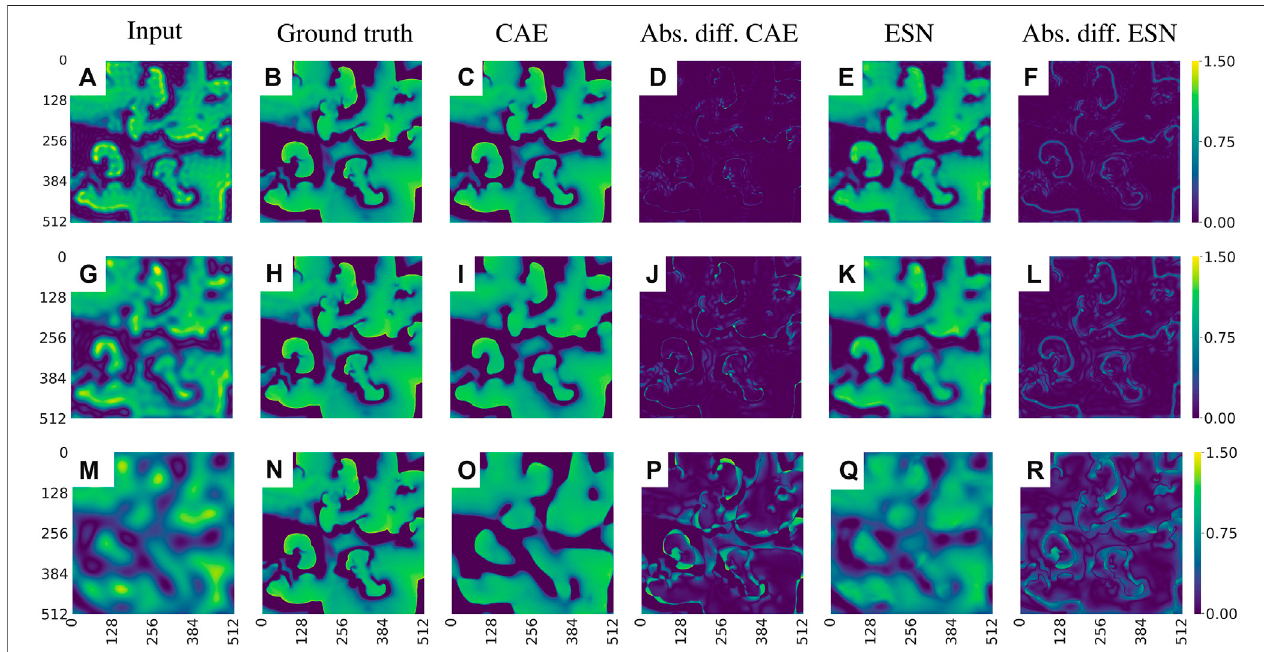
FIGURE 10 | Exemplary visualization of the input and output for both networks, CAE and ESN, when recovering the original data from blurred measurements. (A) – (F) corresponds to case one, where m (cid:2) 20, (G) – (L) to case six with m (cid:2) 14 and (M) – (R) to seven, m (cid:2) 8. Comparing the absolute differences between the prediction and the ground truth [ (D), (J), (P) for the CNN and (F), (L), (R) for the ESN] one recognizes that the CAE and ESN exhibit different patterns. The errors of the CAEareratherpointwisedistributedatsomelocations[see (D),(J) ]onthefrontwhiletheyaremoreevenlydistributedwhenusingESNs (F),(L). Thispatterniseven more pronounced in (P) vs. (R)